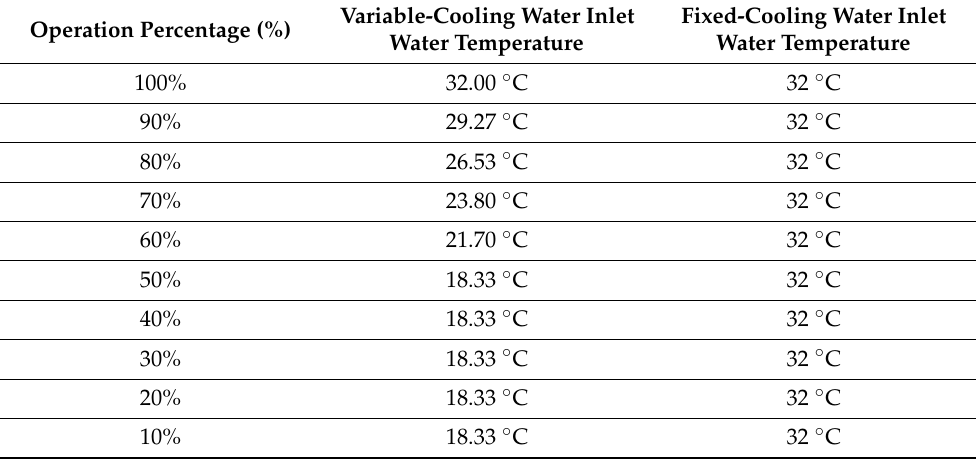
Table 2. Cooling water inlet water